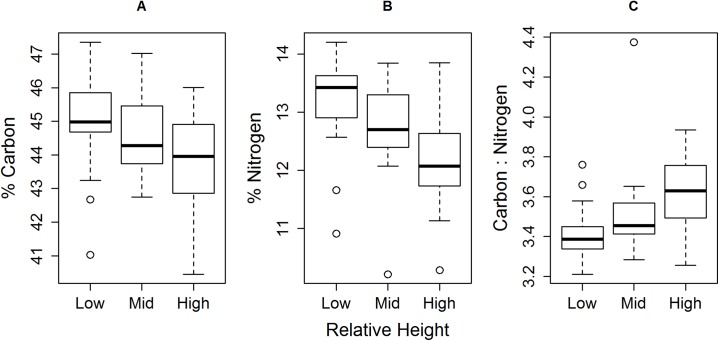
Trend of decreasing (A) % C and (B) % N, and (C) increasing C:N, of E. peruviana muscle tissue with increasing relative shore height.Shown are the median (dark line), inter-quartile range (box), range (whiskers) and outliers (points).